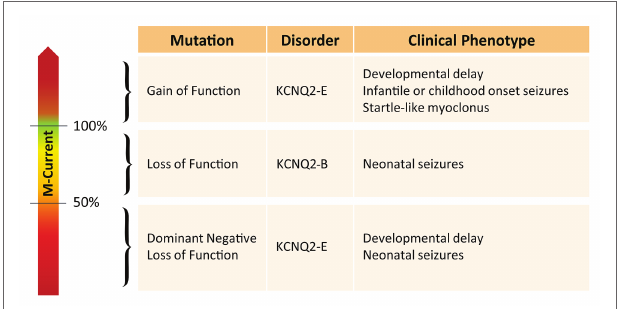
FIGURE 1 | Overview of the effect of different KCNQ2 pathogenic variants on the M-current and their associated clinical